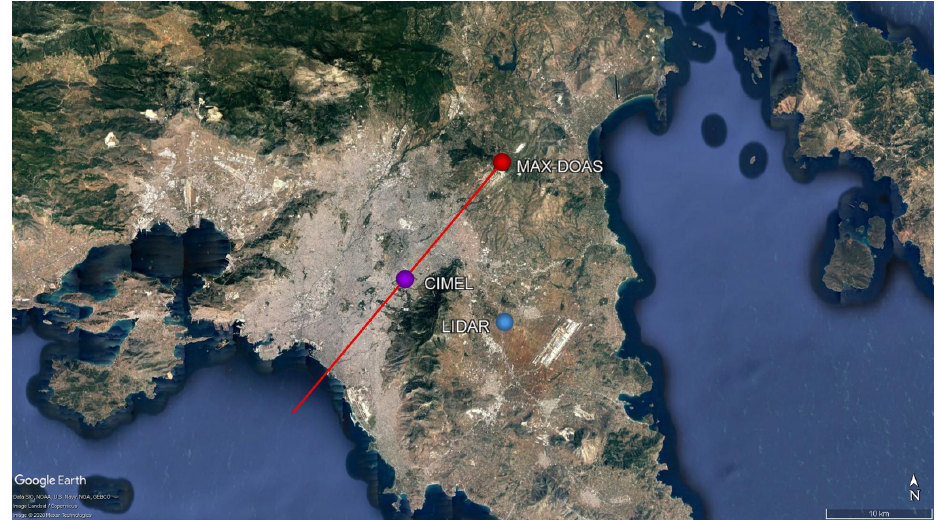
Figure 1. Measurement sites and MAX-DOAS viewing direction ( S ). The distances between instruments are 16km between MAX-DOAS and the sun photometer (CIMEL) and 13km between MAX-DOAS and the lidar. © Google Earth Table 1. Instruments and data products used in the present study. Instrument Location Institute Products MAX-DOAS Penteli National BREDOM network, Institute SCD NO Observatory of of Environmental Physics aerosol extinction Athens (38.05 ◦ N, and Remote Sensing, profile, AOD 23.86 ◦ E; University of Bremen 527ma . s . l . ) EOLE lidar Zografou National Technical University Aerosol backscatter profile, (37.97 ◦ N, of Athens, Laser Remote aerosol extinction profile, 23.79 ◦ E; Sensing Laboratory columnar AOD 212ma . s . l . ) (NTUA-LRSU) CIMEL Thissio National Observatory of Athens, AOD, inversion data products sun–sky 2(37.96 ◦ N, Institute for Astronomy, Astrophysics (ssa, asymmetry factor, radiometer 3.72 ◦ E; Space Application and Remote refractive index, phase function, 150ma . s . l . ) Sensing